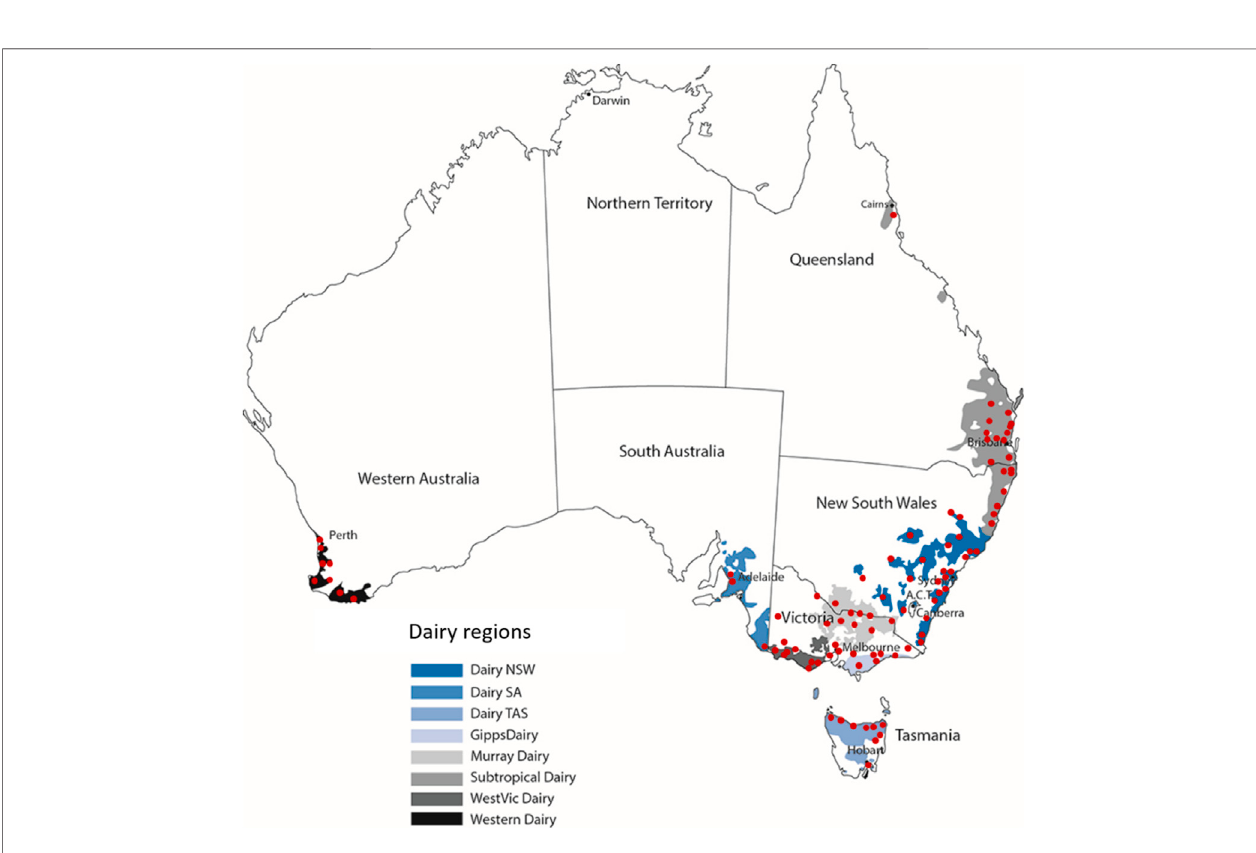
FIGURE 2 | Locations of dairy herds (red points) used in the analysis of heat